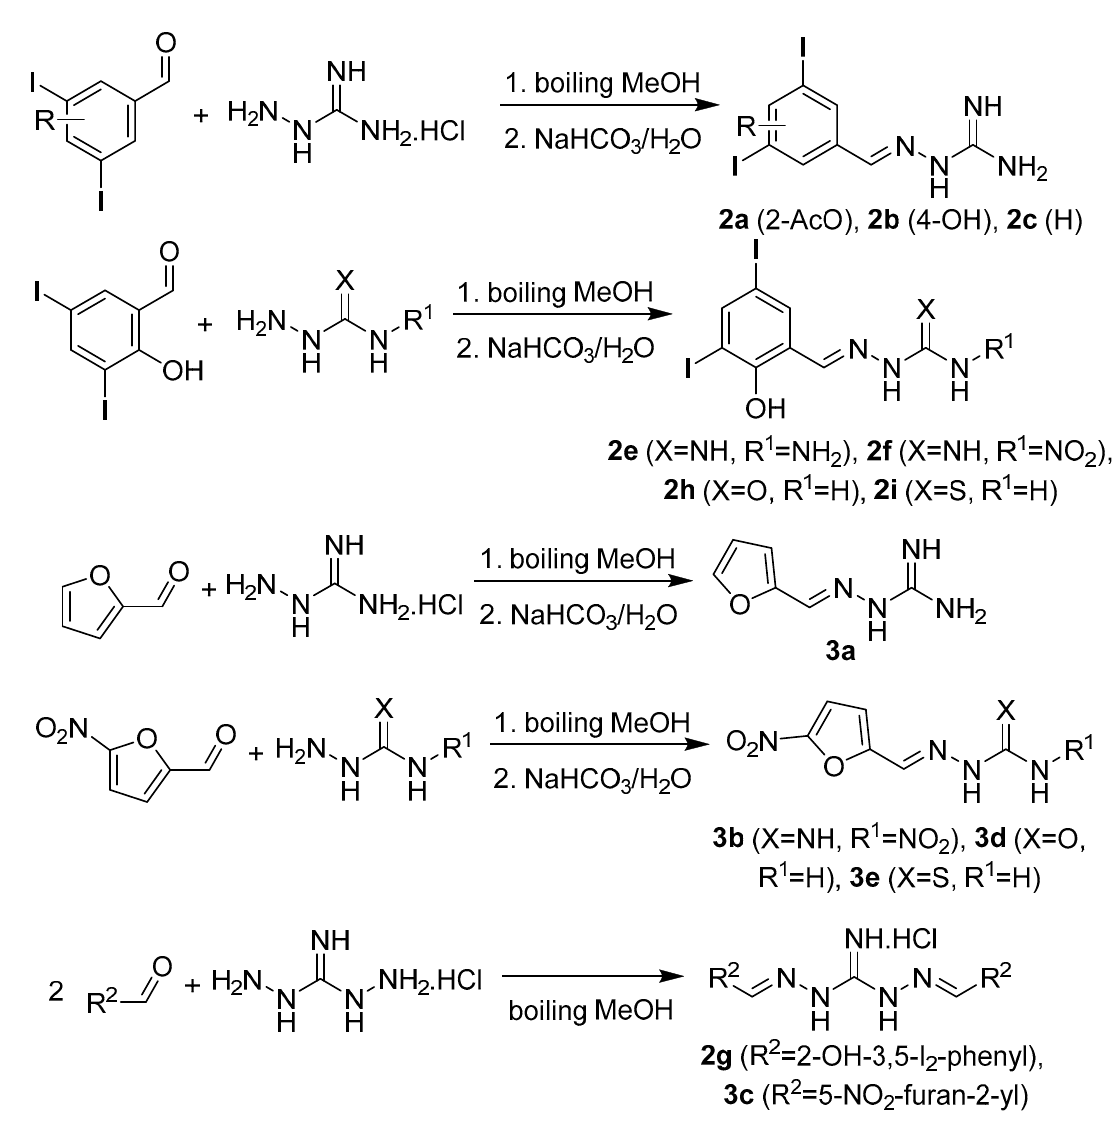
Figure 5. Synthesis of additional series.